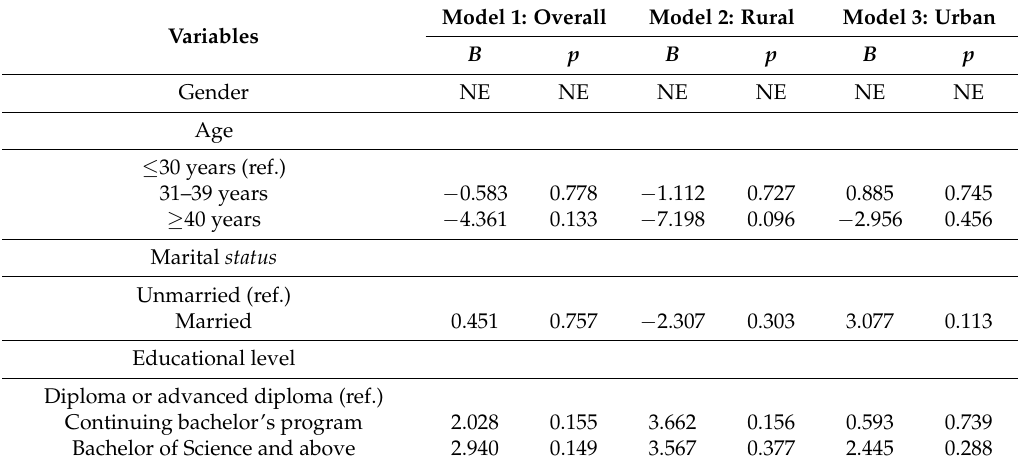
Table 4. Regression analysis on the associated factors of nurses’ attitudes towards online